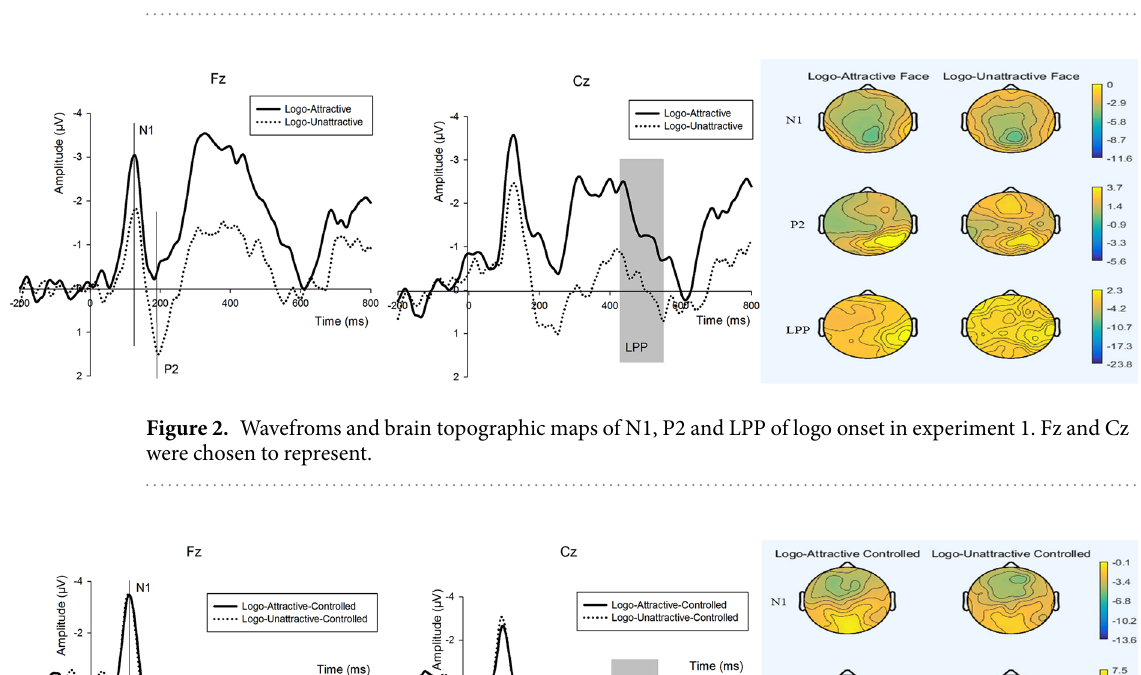
Figure 1. Wavefroms and brain topographic maps of N2, P300 and LPP of female faces onset in experiment 1. Fz and Cz were chosen to represent.